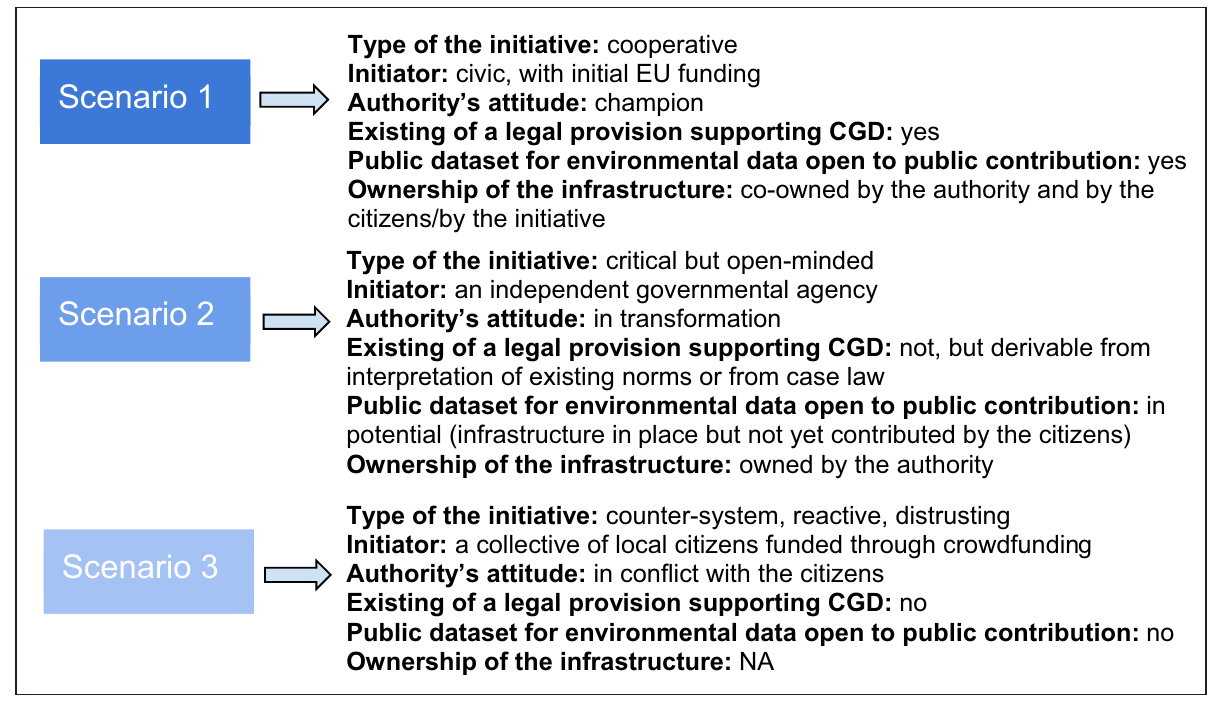
Figure 1 Possible scenarios of interplay between a civic initiative and public